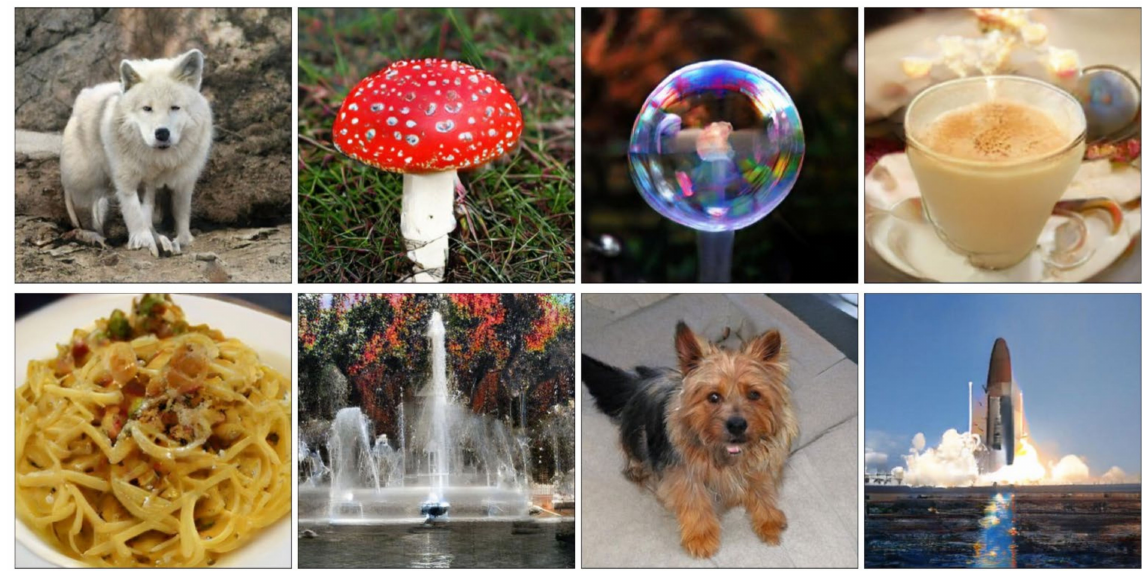
Figure 14. Image generated by BigGAN trained with ImageNet dataset